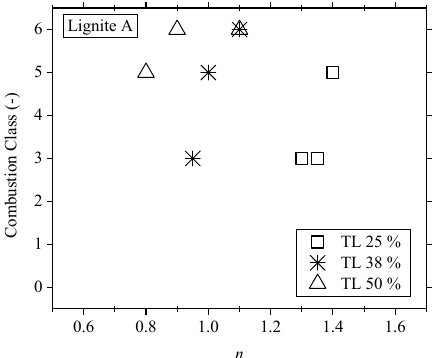
Figure 2. Combustion Class of Lignite